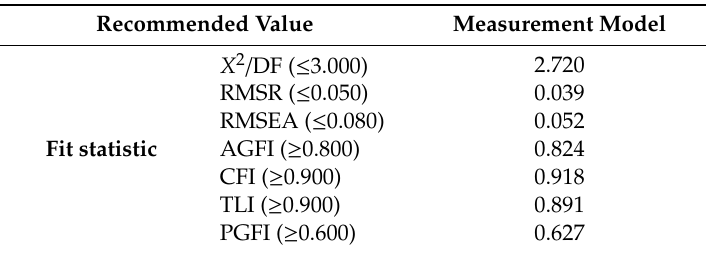
Table 7. Fit statistics for validating the measurement